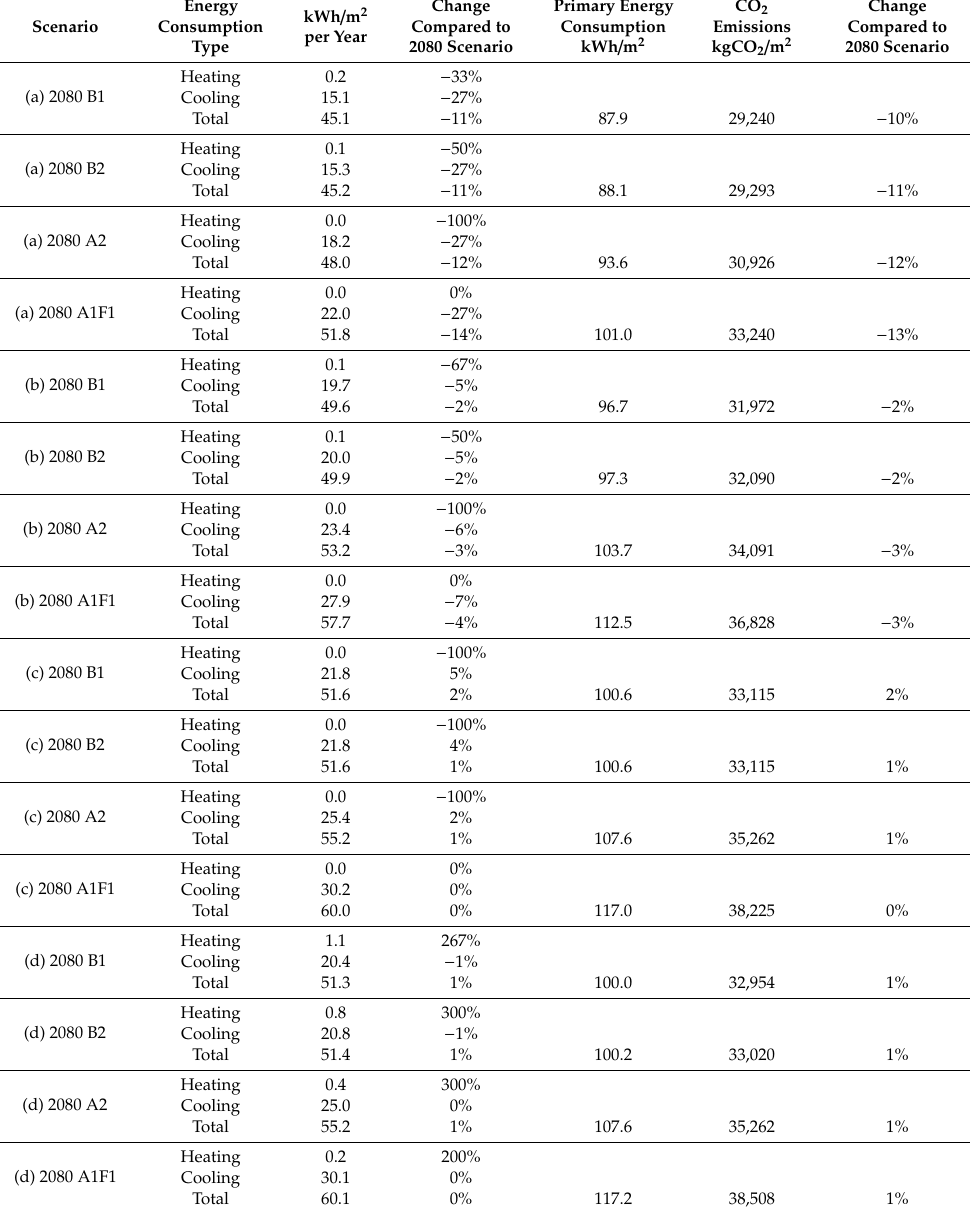
Table A3. Summary of energy consumption and CO 2 emissions in the adaptation models to mitigate the impact of climate change of 2080